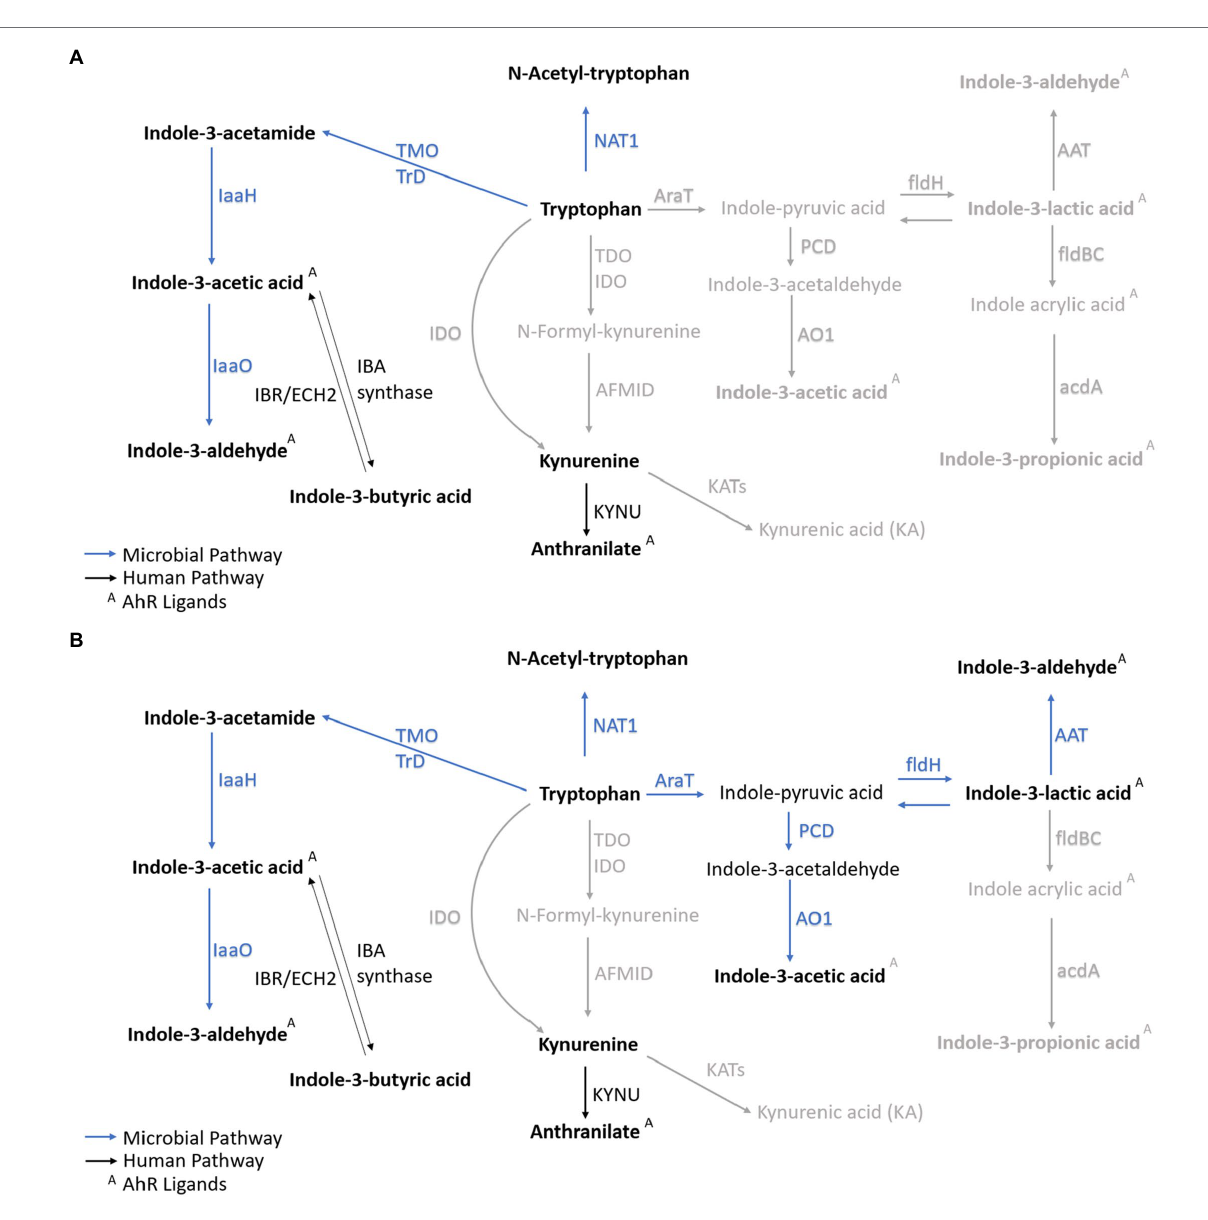
FIGURE 5 | Metabolic profile of VD and CD neonates. Correlated metabolites ( p < 0.01 and/or p < 0.001) in VD neonates (A) and CD neonates (B) are marked in bold. Nonsignificant correlations are marked in gray. The microbial catabolites with significant correlations are highlighted in dark blue. The host metabolism products are marked in black. ArAT, aromatic amino acid aminotransferase, AAT, aromatic amino acid transferase, acdA, acyl-CoA dehydrogenase, AFMID, kynurenine formamidase, AO1, indole acetaldehyde oxidase, ECH2, enoyl-CoA hydratase-2, fldH, phenyl lactate dehydrogenase, fldBC, phenyl lactate dehydratase, IDO, indoleamine-2,3-dioxygenase, IaaH, indole acetamide hydrolase, IaaO, indole-3-acetic acid oxidase, KYNU, kynureninase, KAT, kynurenine amino transferase, MAO, monoamine oxygenase, NAT1, arylamine N-acetyltransferase 1, porB,C, pyruvate ferredoxin oxidoreductase B and C, PCD, pyruvate decarboxylase, TDO, tryptophan-2,3-dioxygenase, TMO, tryptophan-2-monooxygenase, TrD, tryptophan